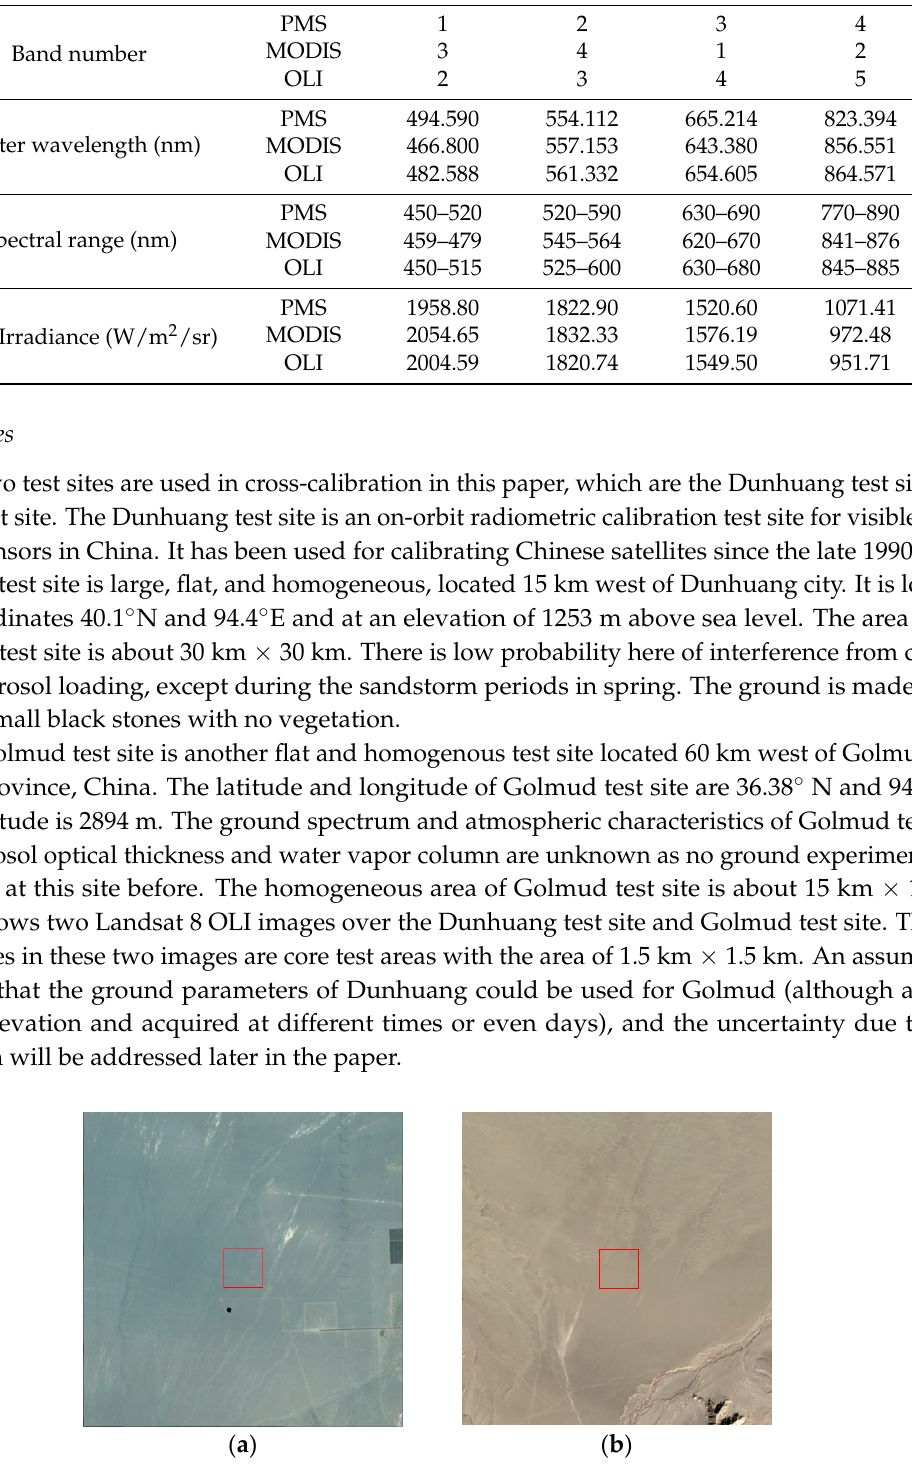
Figure 2. Landsat 8 OLI image over two test sites. The image of Dunhuang test site is imaged on 12 August 2014, and the image of Golmud test site is acquired on 26 February 2014. ( a ) Dunhuang test site; (b) Golmud test site